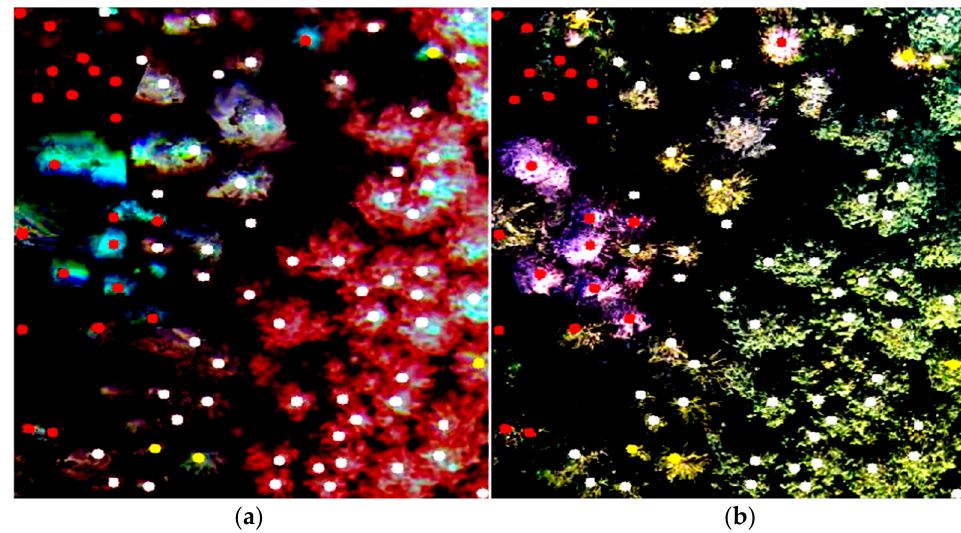
Figure 7. Classification results of tree health conditions (Figures from [113]). ( a ) RGB, ( b ) images in background.